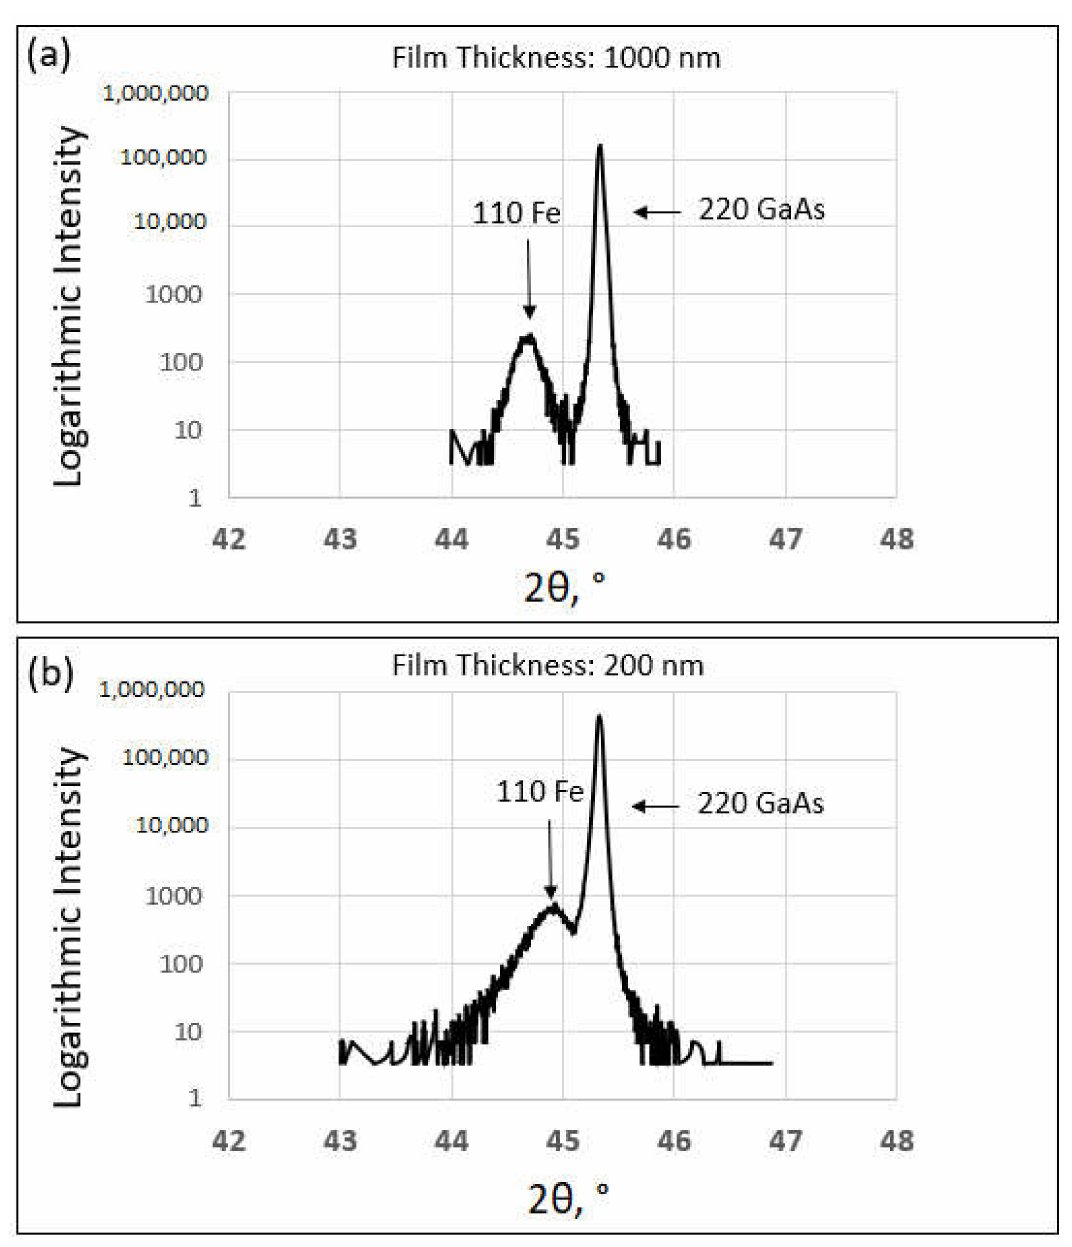
Figure 1. ( a ) XRD of 1000-nm-thick Fe film deposited at room temperature on (110) GaAs, showing the 110 peak of α -Fe phase corresponding to a lattice parameter of 2.865 Å. ( b ) XRD of 200-nm-thick Fe film deposited at room temperature on (110) GaAs showing a lattice parameter of 2.845